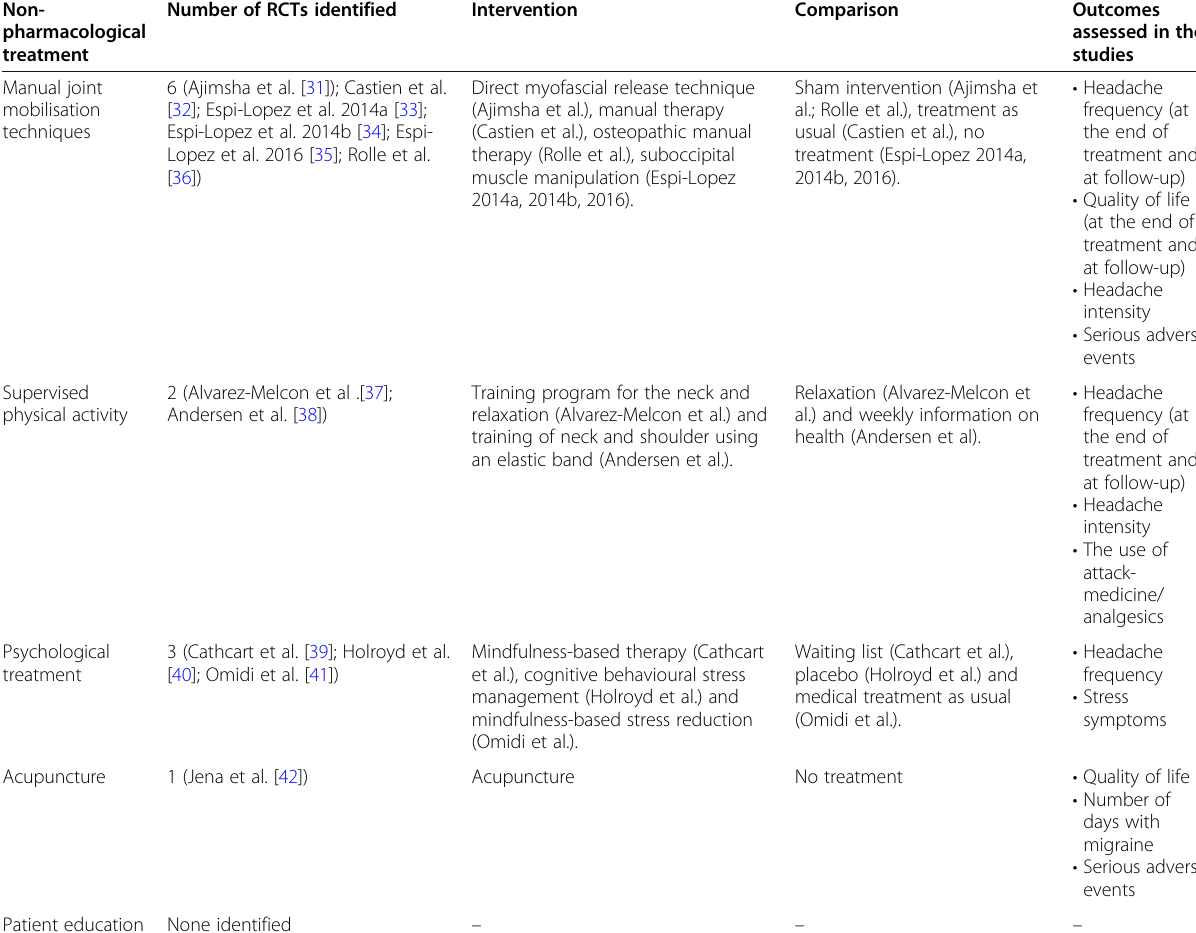
Table 1 Identified randomised controlled trials (RCTs) for non-pharmacological treatments for tension-type headache. Studies were found in existing guidelines and systematic reviews, or via a search for individual